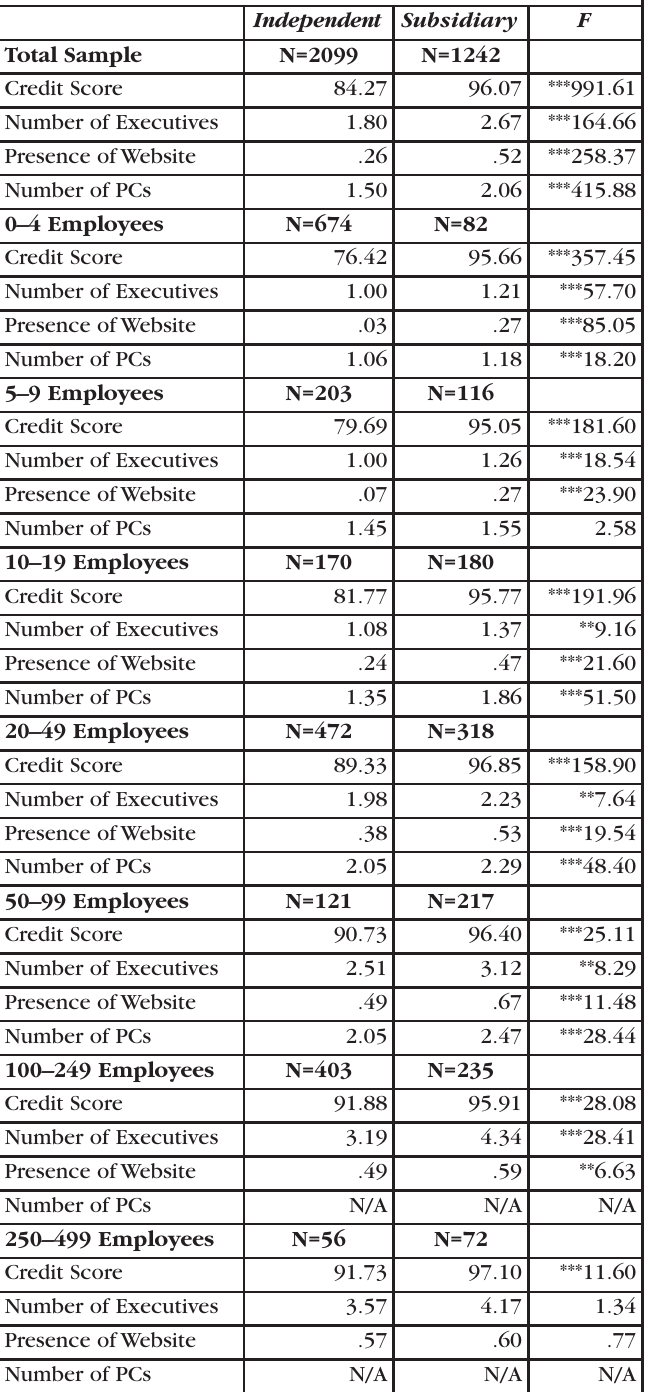
Table 3. Mean Differences Between Small Independent and Subsidiary Retail